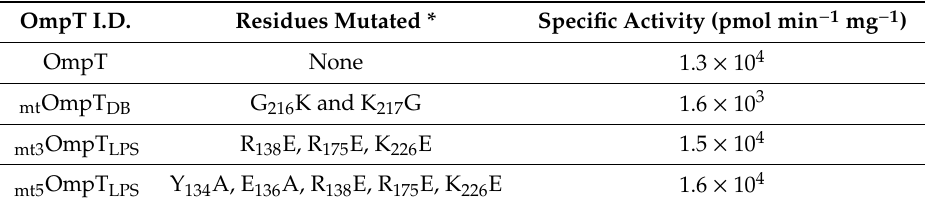
Table 1. Specific activity of wild type OmpT and the various mutants used in this study.